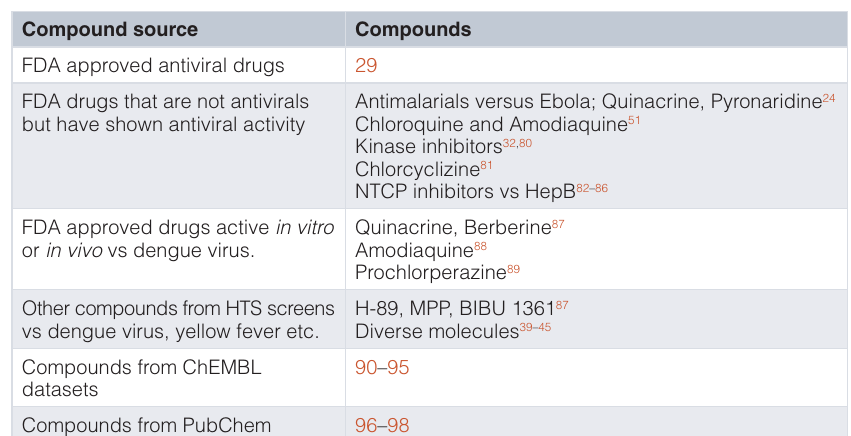
Table 2. List of potential compounds to